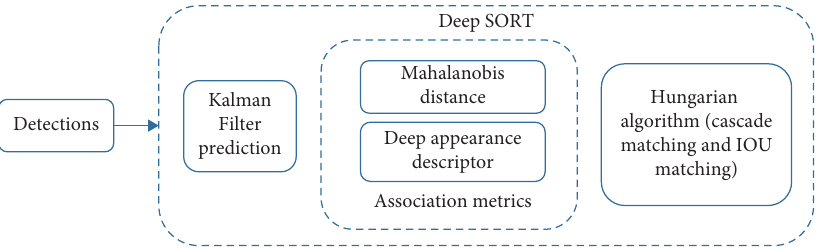
Figure 5: A block diagram depicts data flow in Deep SORT to track the vehicle between frames. Kalman Filter predicts trajectory tracks, while the Hungarian algorithm matches the predicted trajectory tracks with the detected objects in the